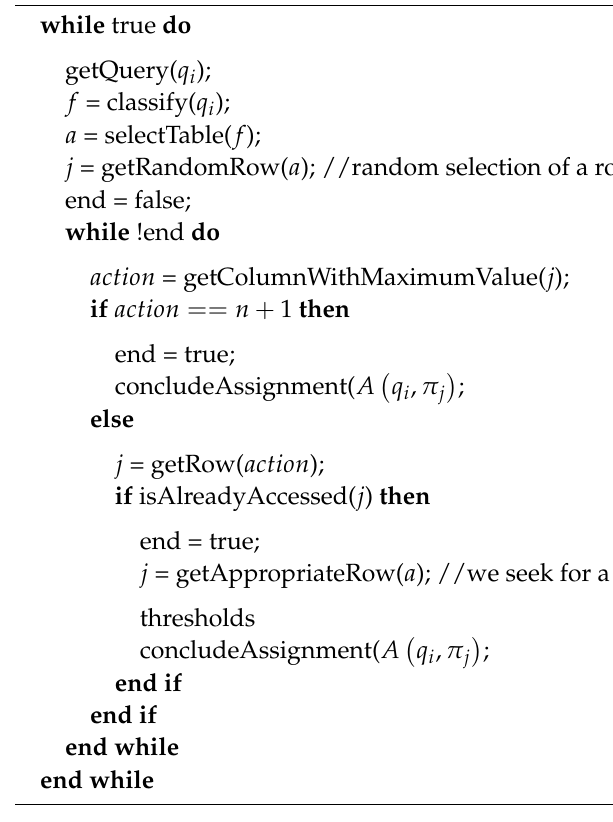
Algorithm 1 The assignment